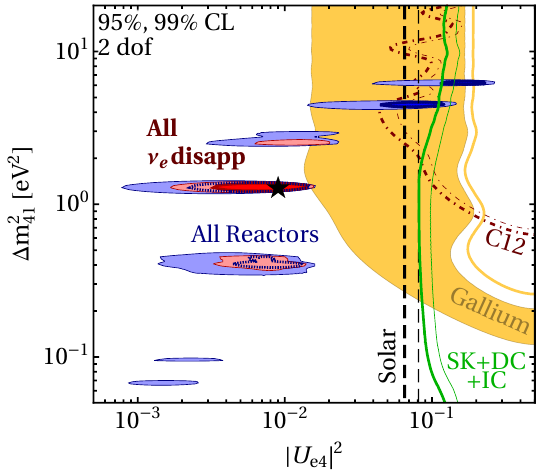
– ) ν Figure 10: Combined ( disappearance results, assumming free reactor flux nor- e malisation. All the parameter space inside the coloured regions is allowed, and the parameter space to the right of the solid lines disallowed. Figure extracted from Ref. [ 13 ]